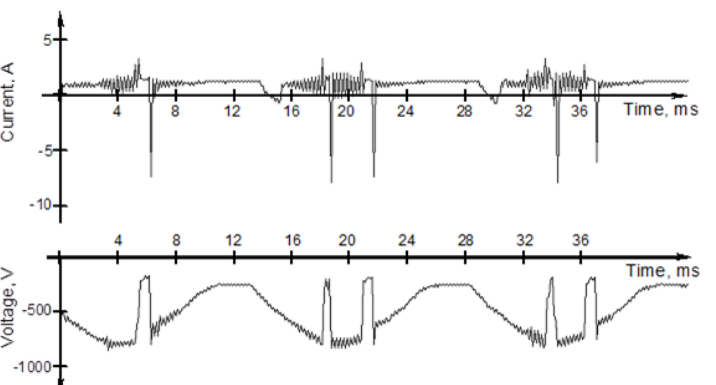
Figure 4. Typical current-voltage waveforms of the plasma glow-discharge furnace power supply. The visible steep peaks are probably due to the inductive influence of the plasma.